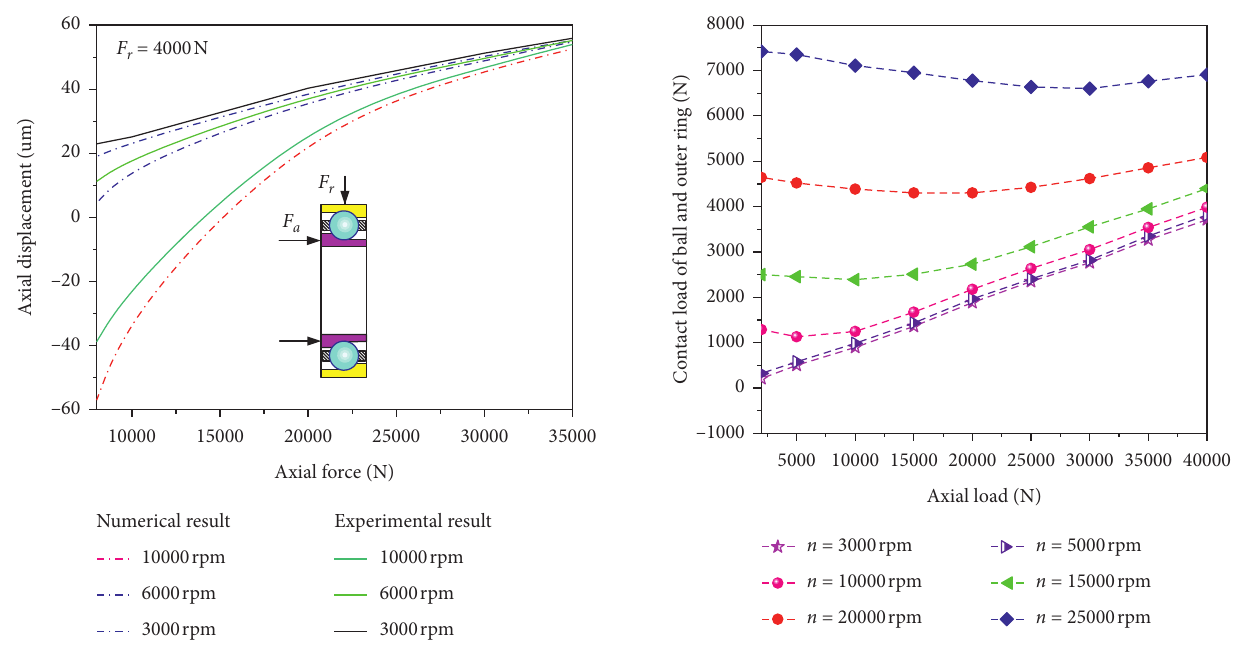
Figure 14: Axial deformation under axial load and radial load.